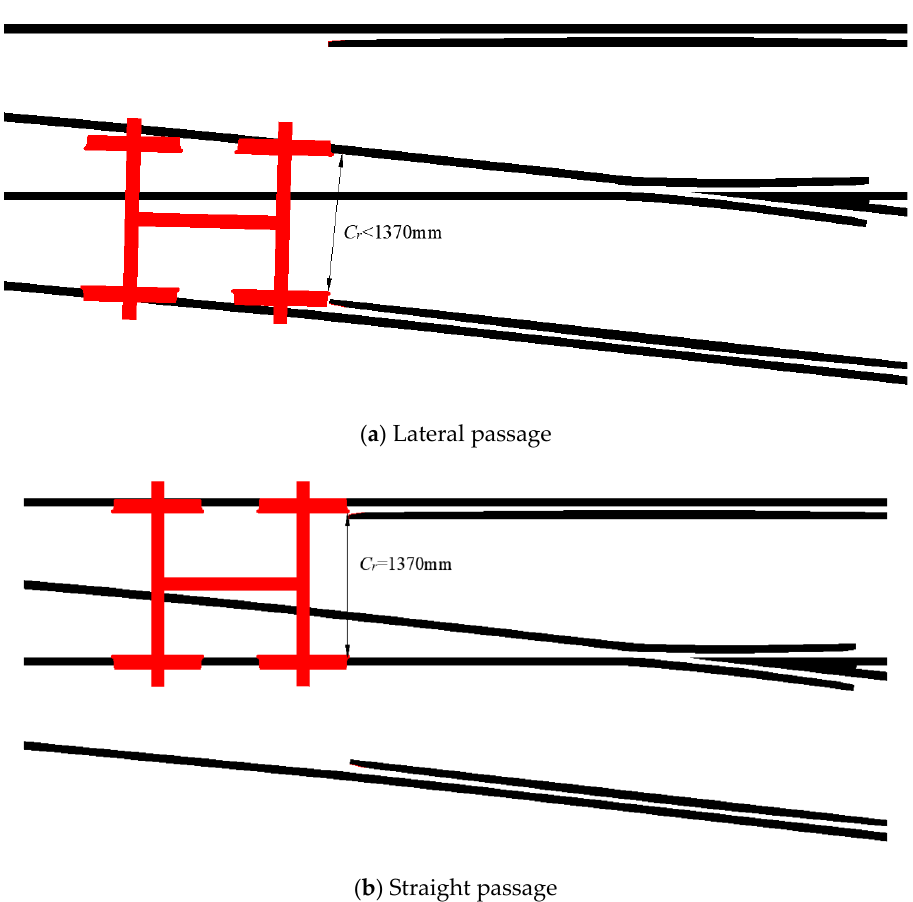
Figure 4. Vehicle running attitude when passing through the turnout. 3. Proposed Calculation Method of the Guardrail Interval Limit Based on the Vehicle Running Attitude